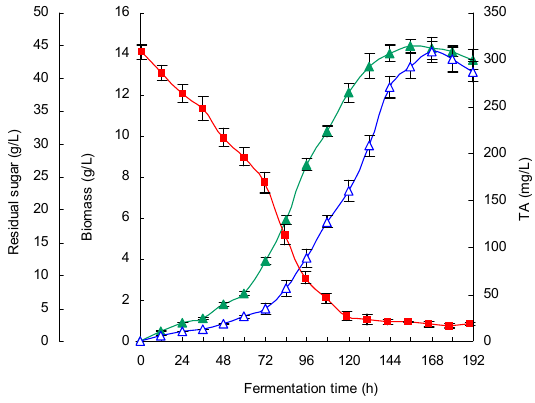
Figure 4. Time courses of sugar consumption ( ■ ), mycelial growth ( ▲ ) and mycelial triterpene acid (TA) production ( △ ) during Ganoderma lingzhi growth in a 5 L stirred-tank bioreactor under the optimized fermentation conditions. Medium volume, 3.5 L; initial pH, 5.9; fermentation temperature, 28.6 °C; DO, ~20.0%; aeration rate, 0.3 vvm; culture time, 8 days.